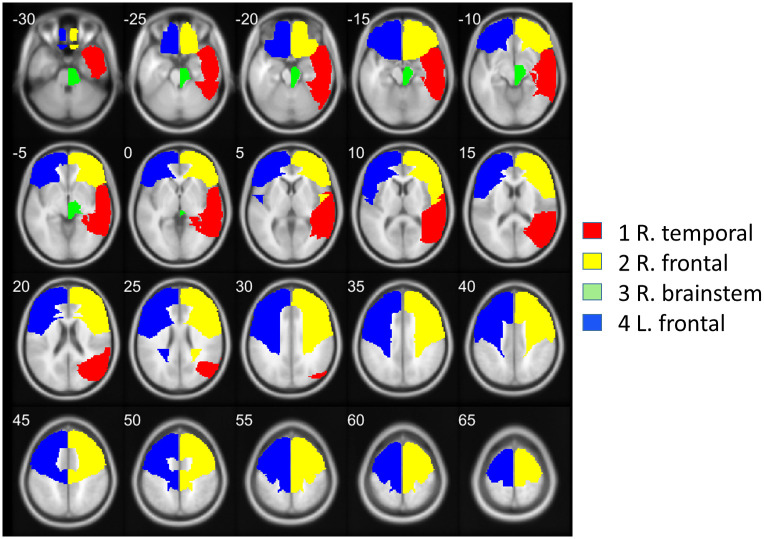
Axial slices of the lobes area with different GMV between groups, in the order of 1 to 4, following statistical significance.Z coordinates are shown in mm from the anterior-posterior commissure. The right side of the image corresponds to the right side of the brain.